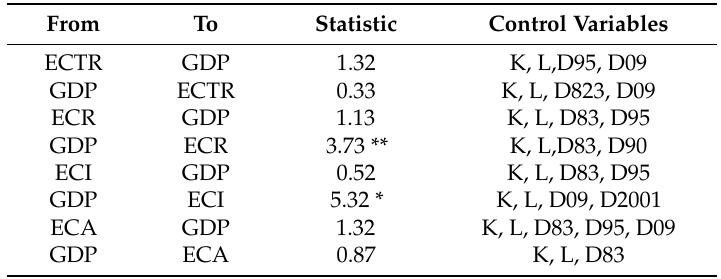
Table A3. Toda and Yamamoto causality test results: Disaggregated level. To